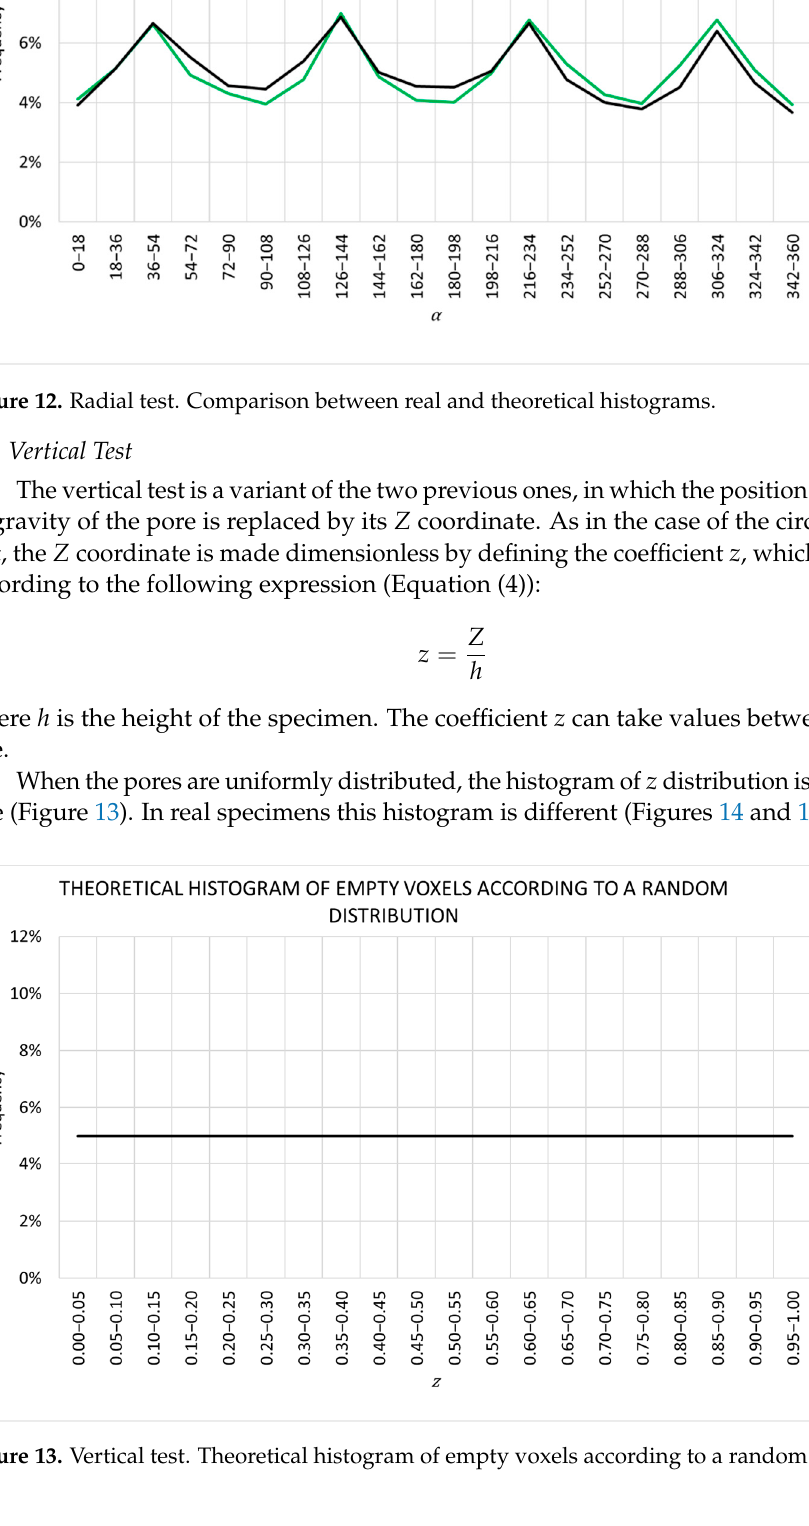
Figure 14. Vertical test. Real histogram of empty voxels.